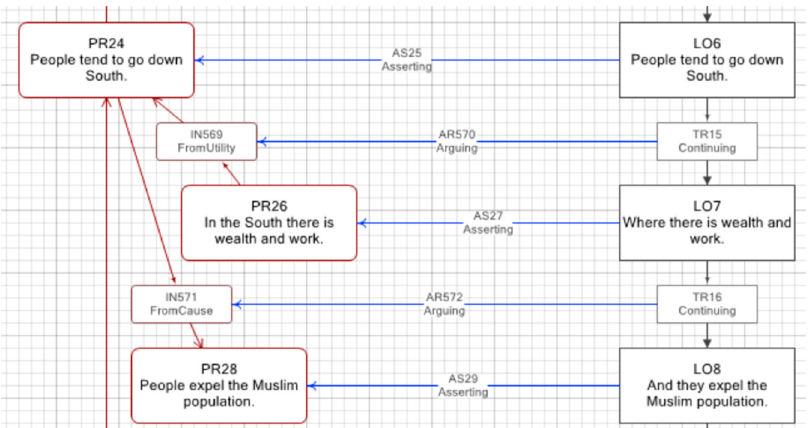
Figure 2. An IAT + diagram showing the text fragment mentioned above. Locutions are shown as large boxes on the right-hand side, whereas propositions are shown as large boxes on the left. Note that two inferences, labelled IN569 and IN571, indicate how propositions are argumentatively related. The diagram was prepared with LogosLink, a software tool developed by the author.